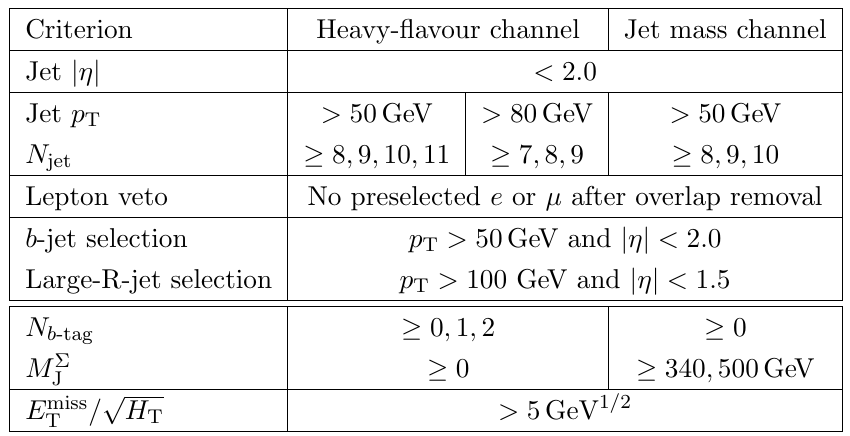
Table 1. Summary of the selection criteria for all signal regions used in this analysis. In each column, the three selection criteria on the number N b -tag of b -tagged jets or the two on the sum M (cid:6) of masses of large-radius jets are applied to de(cid:12)ne separate signal regions for each of the jet J multiplicities